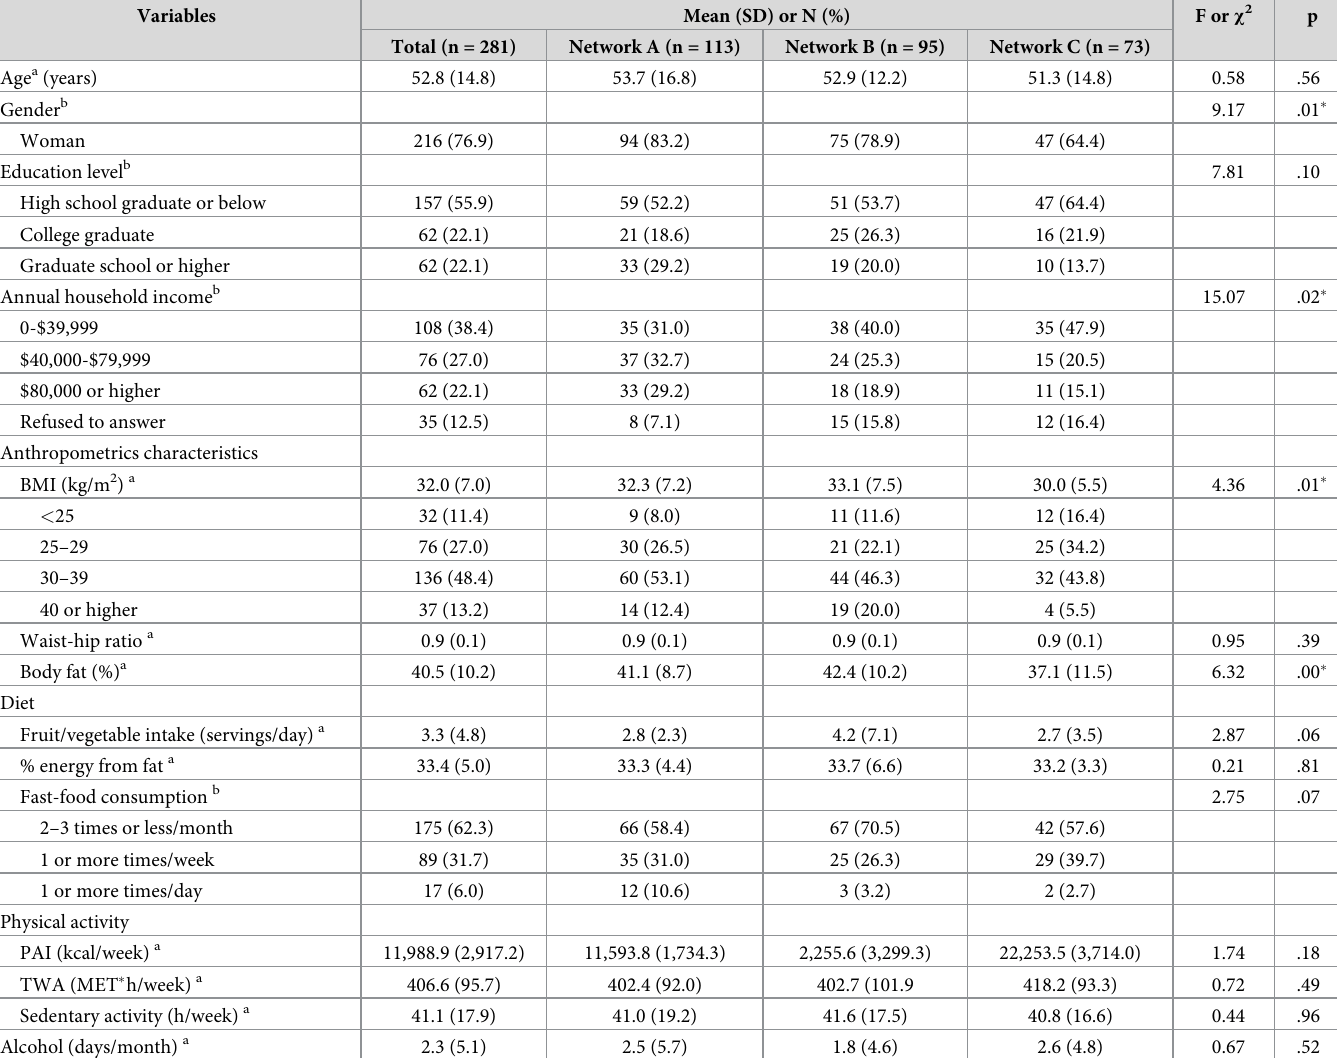
Table 2. Description of sociodemographic characteristics, body mass index, and obesity-risk behaviors (n = 281).